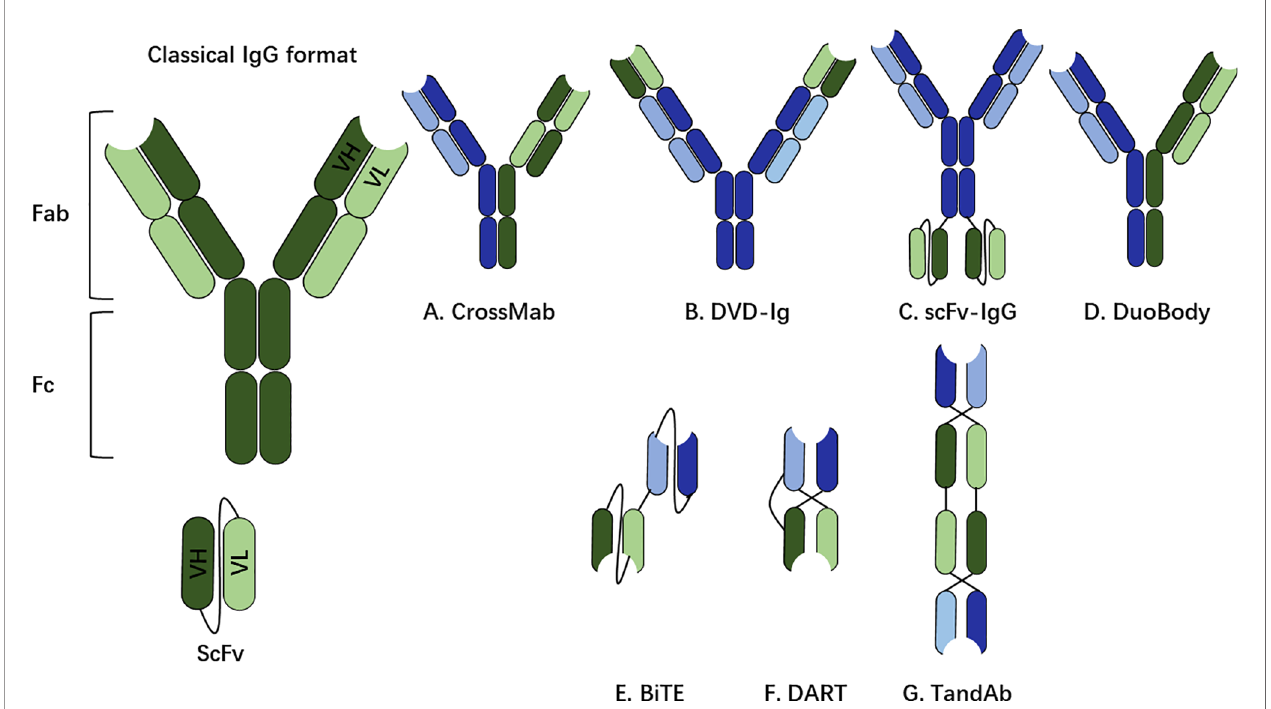
FIGURE 2 | The non-IgG-like format and IgG-like format. The classical structure of a human immunoglobulin G (IgG) for reference, including fragment crystallizable (Fc) region and fragment antigen-binding (Fab). The binding part of the Fab region is called the single chain variable fragment (scFv), which is a synthetic protein composed of the heavy (VH) and light (VL) chains connected by a short peptide linger. (A – D) IgG-like bsAb formats (with Fc region). (E – G) non-IgG-like bsAb fragments (without Fc region). CrossMab Cross monoclonal antibody, DVD-Ig, dual-variable-domain immunoglobulin; scFv, single-chain variable fragment; BiTE, bispeci fi c T-cell engager; DART, dual-af fi nity retargeting molecule; TandAb, tandem